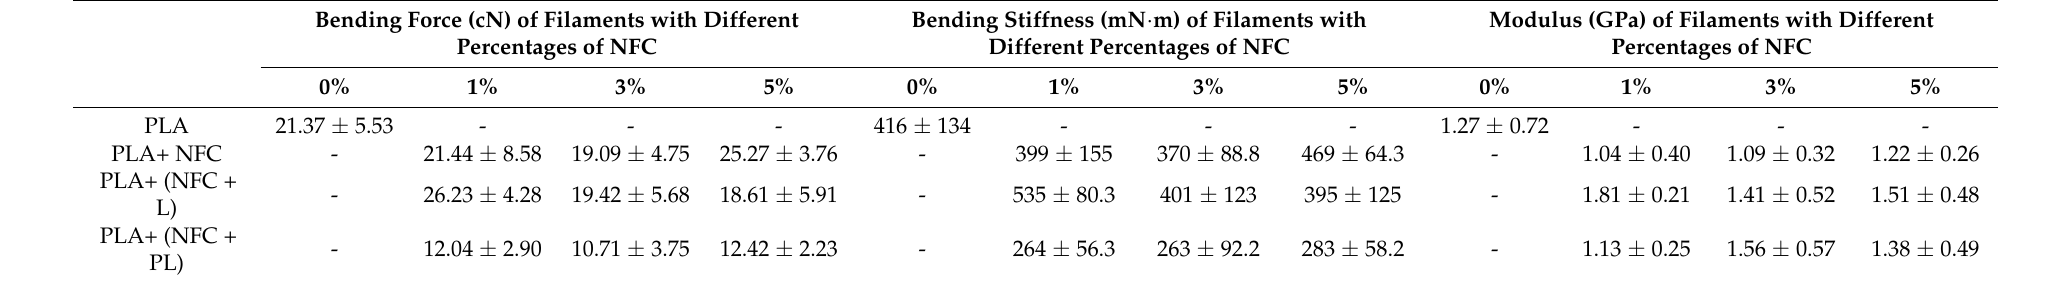
Table 6. Bending force, bending stiffness, and modulus of filaments; mean value ±